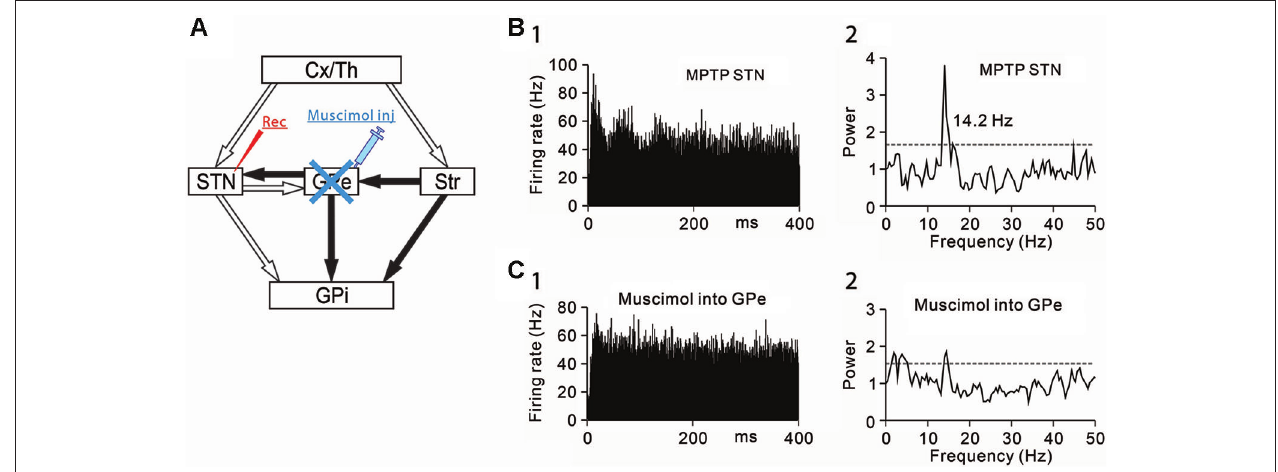
abnormal 8–15 Hz oscillations under the parkinsonian state. (C) Muscimol inactivation of the GPe decreased the 8–15 Hz oscillations and increased the firing rate of the STN neuron. Modified from Tachibana et al. (2011).